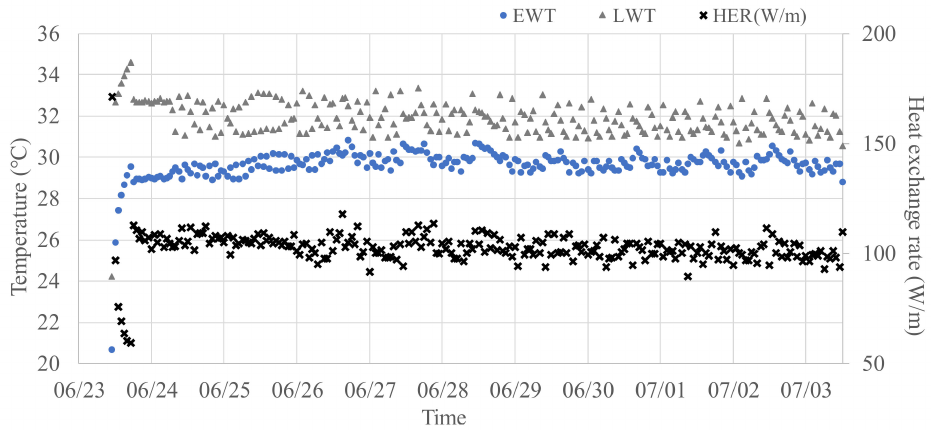
Figure 13. Fluctuation of EWT, LWT, and HER in Case 5.